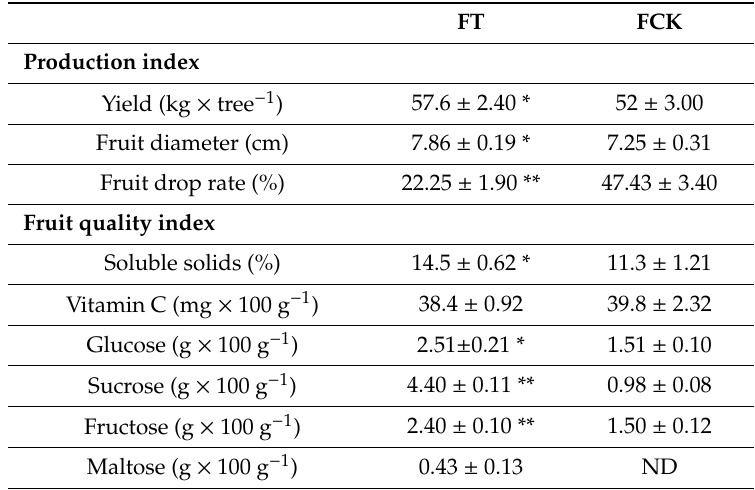
Figure 3. Temporal variation of the titre of ’ Candidatus Liberibacter asiaticus’ (CLas) in leaf midrib samples under di ff erent Soil acidity conditions. ( A ) In the field and ( B ) greenhouse trials, the CLas titre in infected leaves were measured at each time point using q-PCR. Data represent the means (three biologically independent experiments for quantification of CLas) ± SD. FCK, control grove in field trial; FT, treatment grove in field trial; GCK, control group in greenhouse trial; GT, treatment group in greenhouse trial; FW, fresh weight. Table 1. Fruit yield and quality of HLB-infected citrus cultivated under two soil